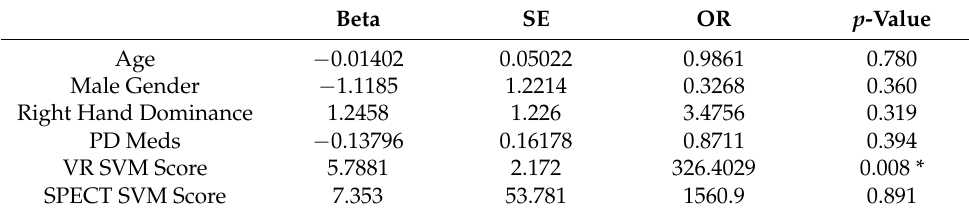
Table 4. Logistic regression results comparing age, gender, hand dominance, Parkinson disease (PD) medications, as well as VR and [ 123 I]FP-CIT SPECT SVM scores for detection of CID in motor dysfunction.